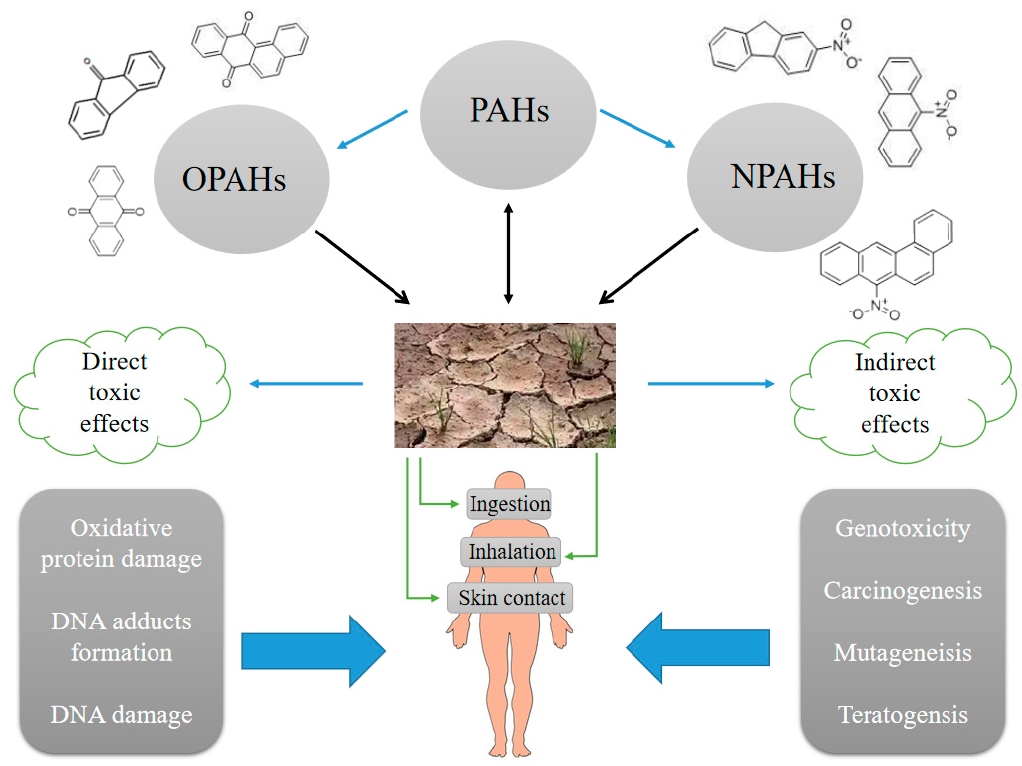
Figure 3. Toxic effects of OPAHs and NPAHs in soil.